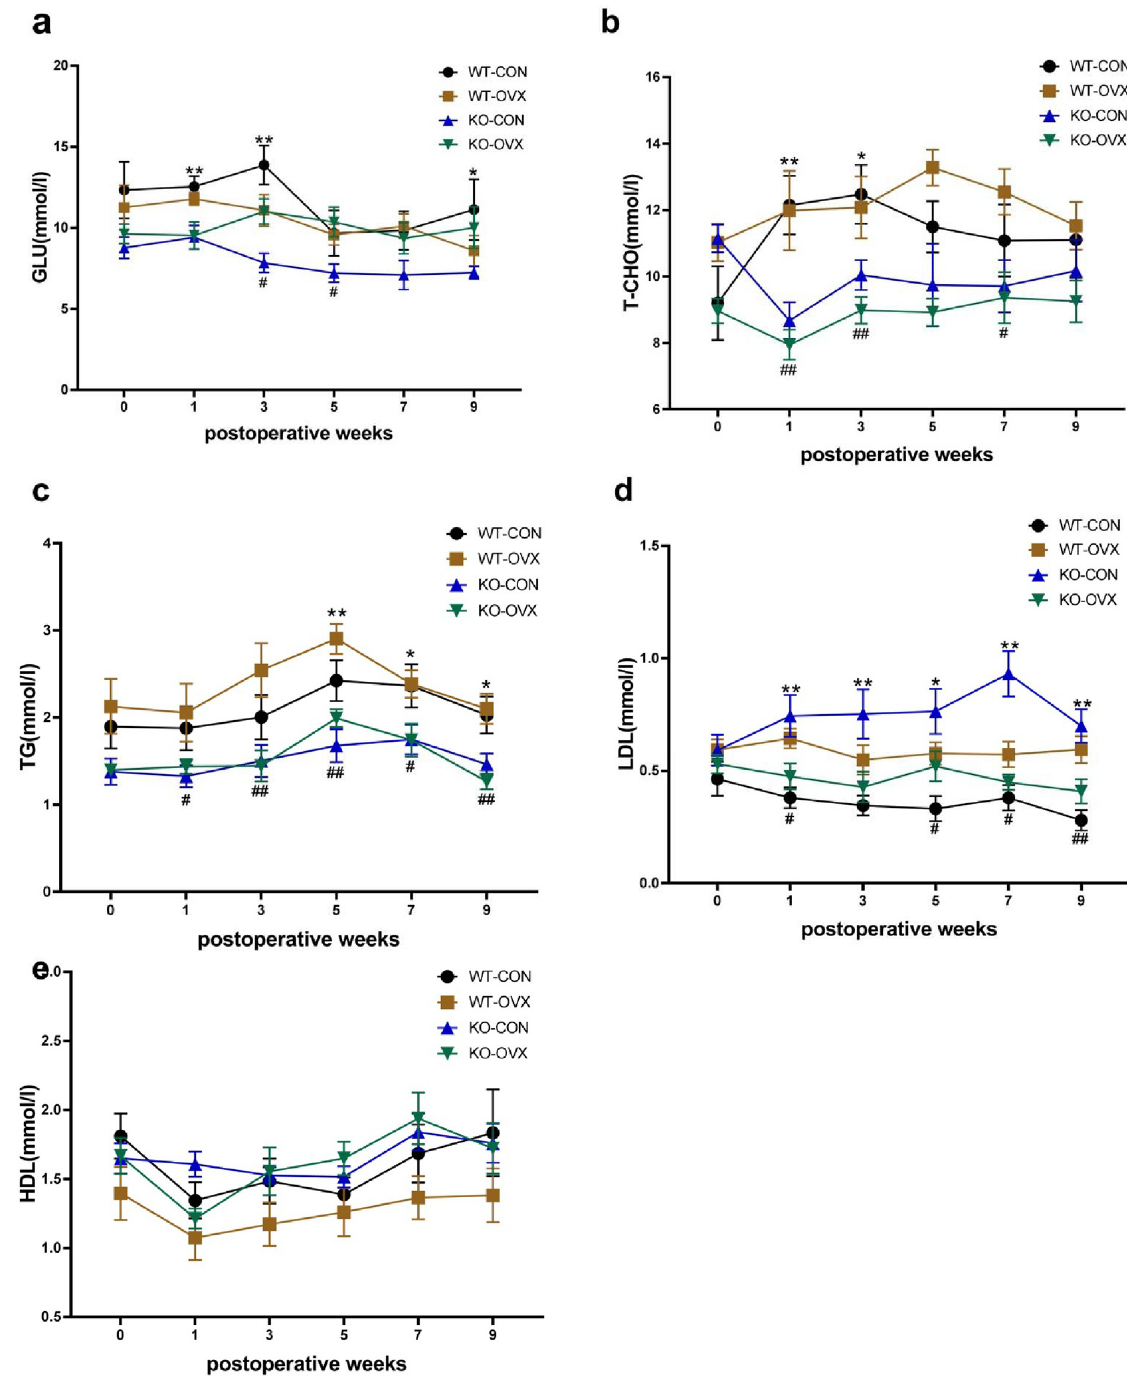
Fig 4. Changes in different metabolic indicators in different groups of mice over time. WT-CON: wild-type control, WT-OVX: wild-type ovariectomy, KO-CON: Nrf2−/− control, KO-OVX: Nrf2−/− ovariectomy. Curves showing the changes in serum metabolite levels preoperatively (week 0) and at postoperative week 1, 3, 5, 7, and 9 in different groups of mice. (a) Change curve of glucose levels. � P < 0.05; �� P < 0.01 (KO-CON vs WT-CON); # P < 0.05 (KO-OVX vs KO-CON). (b) Change curve of T-CHO levels. � P < 0.05; �� P < 0.01 (KO-CON vs WT-CON); # P < 0.05; ## P < 0.01 (KO-OVX vs WT-OVX). (c) Change curve of TG levels. � P < 0.05; �� P < 0.01 (KO-CON vs WT-CON); # P < 0.05; ## P < 0.01 (KO-OVX vs WT-OVX). (d) Change curve of LDL levels. � P < 0.05; �� P < 0.01 (KO-OVX vs KO-CON); # P < 0.05; ## P < 0.01 (WT-OVX vs WT-CON). (e) Change curve of HDL levels. Results are shown as mean ± SEM. Data were analyzed by One-way ANOVA with Bonferroni’s Multiple comparison test.